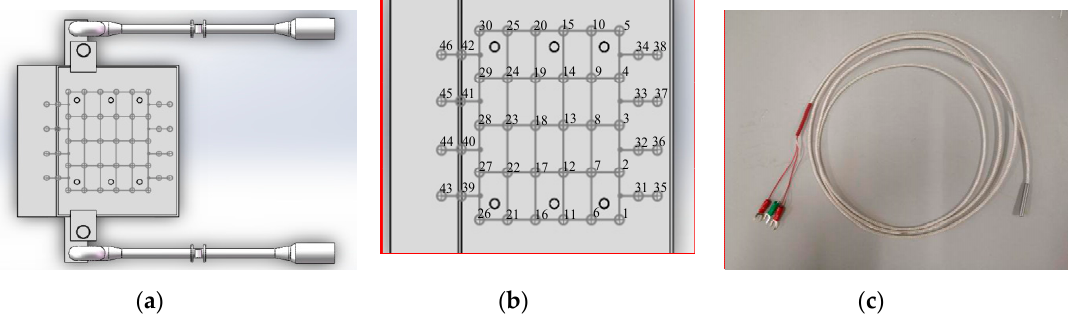
Figure 14. Illustration of ( a ) distribution of temperature sensors, ( b ) sensor locations, and ( c ) a PT100 temperature sensor.